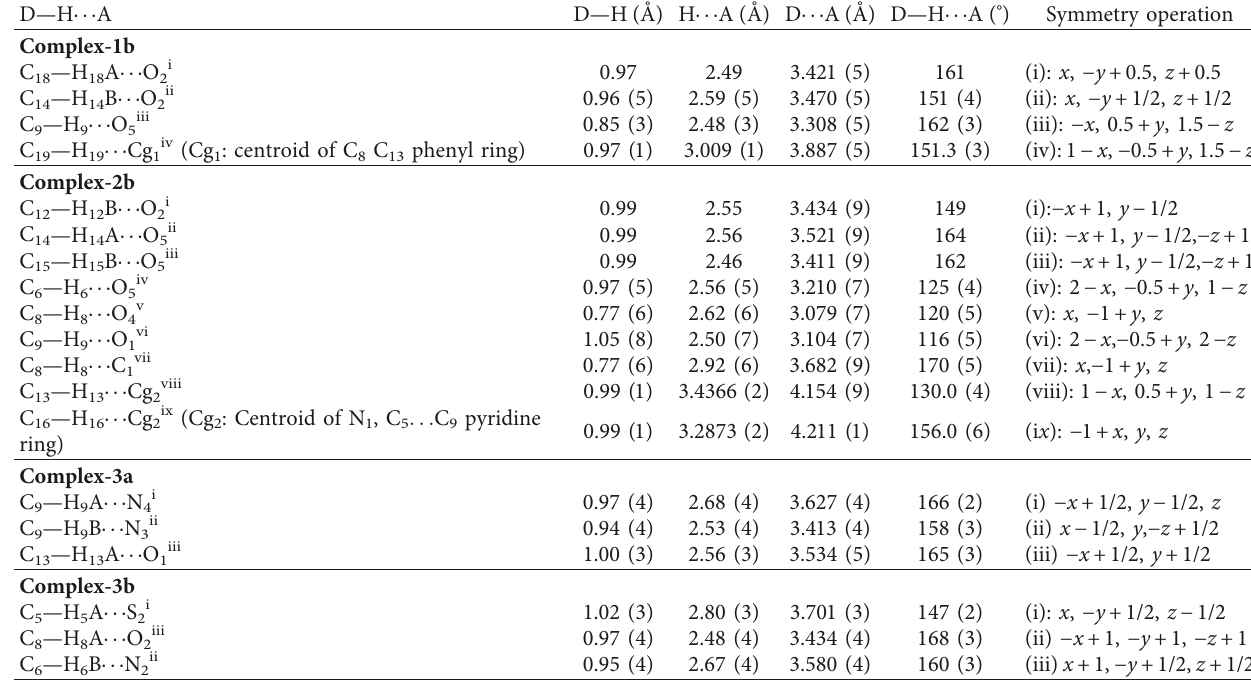
Table 5: Hydrogen-bond geometry (˚A, ° ) for 1b , 2b , 3a, and 3b